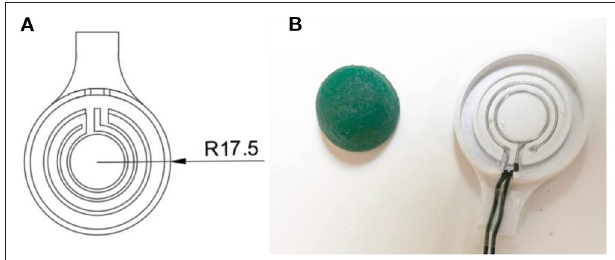
FIGURE 3 | (A) The left side shows a simplified technical drawing of the electrode plate, while the right side (B) shows the wired plate next to the soaked